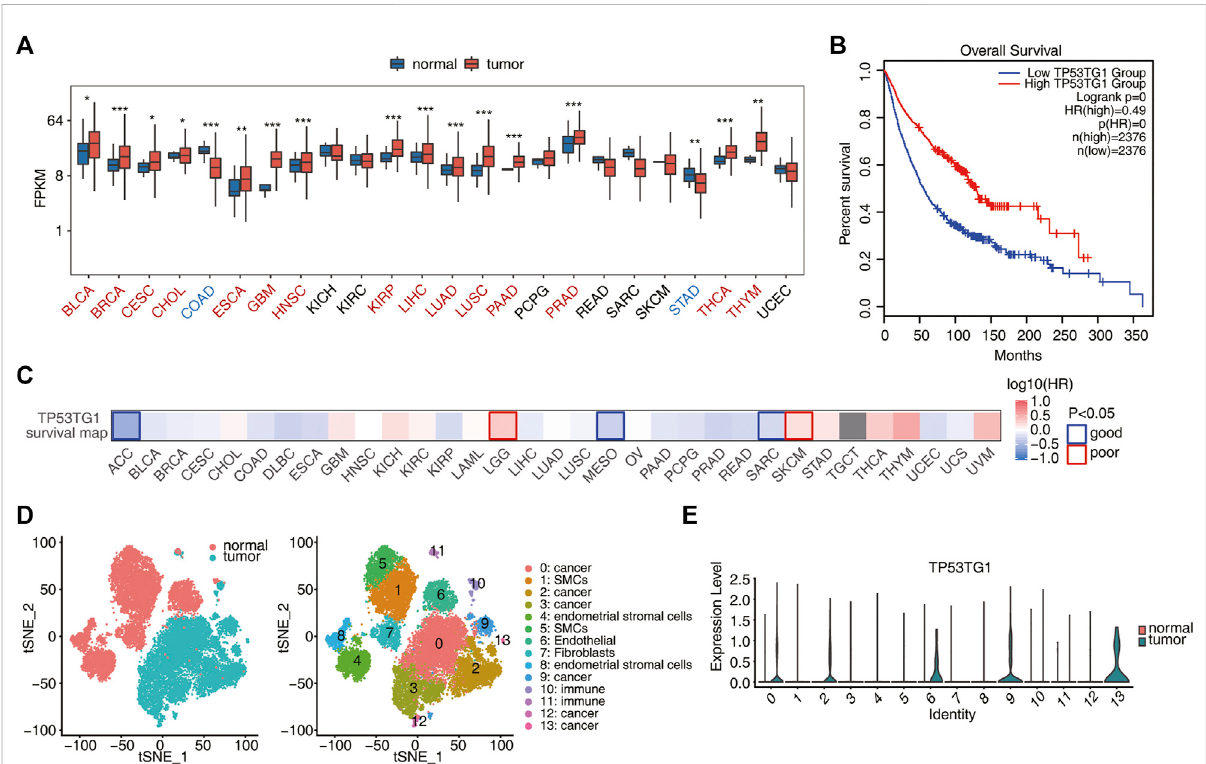
FIGURE 1 Pan-cancer analysis shows that high expression of TP53TG1 is associated with a good prognosis. (A) Relative expression (FPKM) of TP53TG1 in tumor samples (red) compared with in normal samples (blue) in 24 cancer types from TCGA. * p < 0.05; ** p < 0.01; *** p < 0.001. (B) Association of TP53TG1 expression with the survival rates is elucidated for comparison between upper quartile and lower quartile patients from TCGA pan-cancer dataset. (C) Association ofTP53TG1expressionwiththesurvival ratesinvarioustypes ofcancer. (D) Single-cellRNA-seq data from onecervical cancertissuesampleandonenormaladjacenttissuesampleweredownloadedfromGSE168652,respectively. CelltypeswithcellclusteridfortSNE plotaresummarizedintherightpanel. (E) ViolinplotshowingtheexpressionalternationofTP53TG1betweentumorandnormalsamplesindifferent cell